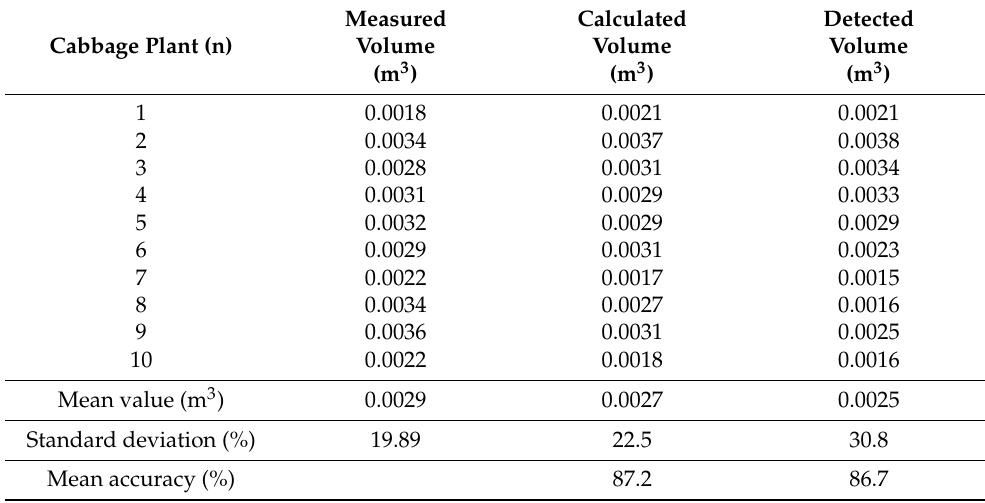
Table 2. Comparison of measured volume, calculated volume, and detected volume in regard to the calculated results of BBCH stage 48.